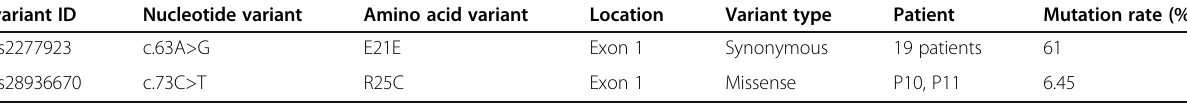
Table 2 NKX2.5 variants detected in non-syndromic tetralogy of Fallot cohort variant